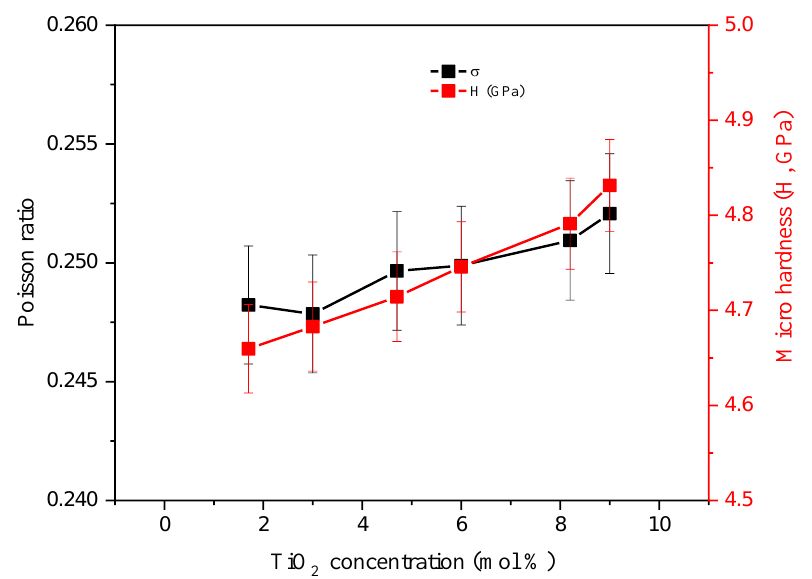
Figure 5. Dependence of the Poisson ratio and microhardness on TiO 2 concentration. Declining temperatures were predicted for the investigated glass samples (Table 2).